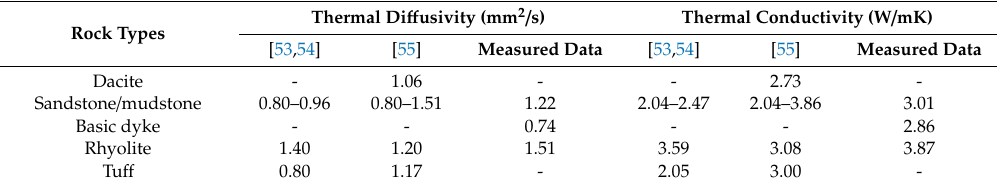
Table 2. Comparison of reference and measured values of thermal di ff usivity and thermal conductivity for di ff erent rock